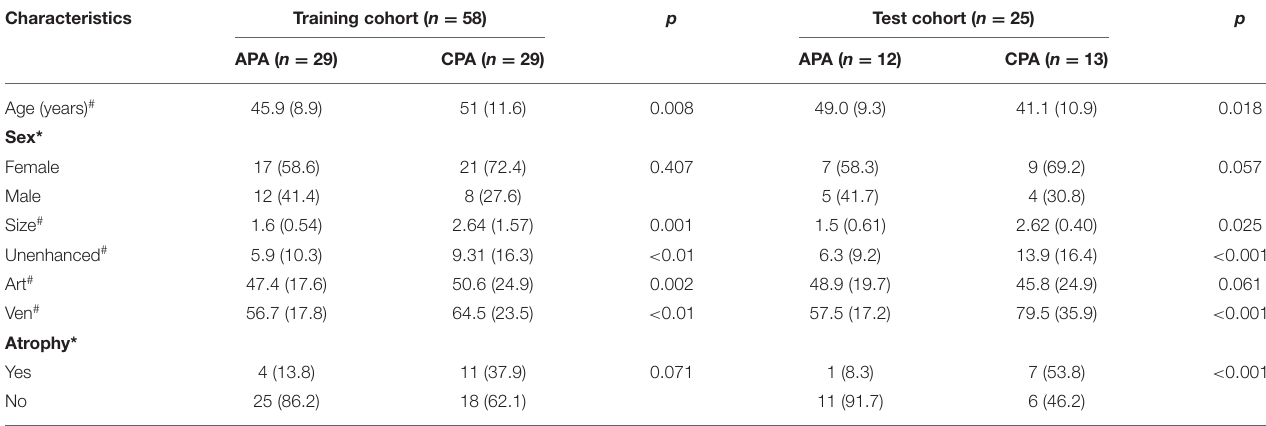
TABLE 2 | Clinical characteristics and CT findings of patients with CPA and APA. Characteristics